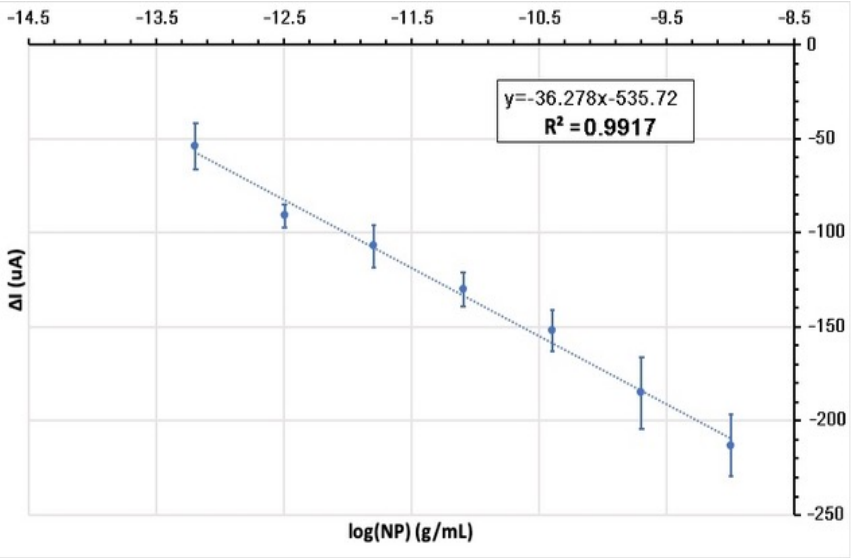
Figure 7. Calibration graph: linear technique of analysis of the recorded current signal suppression ( Δ I) analytical curve of modified electrodes incubated in different NP concentration for 10 min plotted against the logarithmic function of NP concentrations.